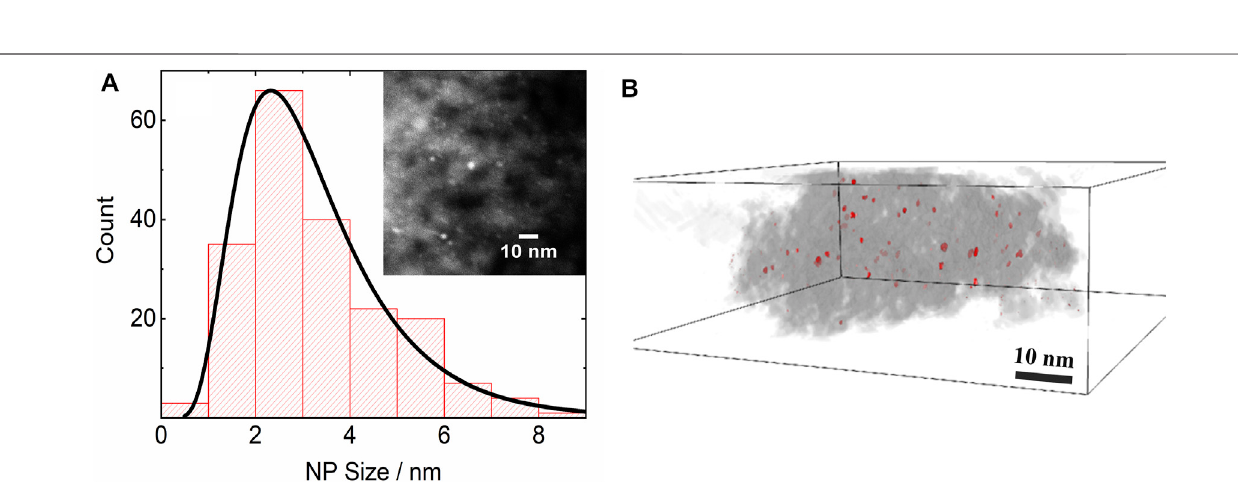
Frontiers in Chemical Engineering |